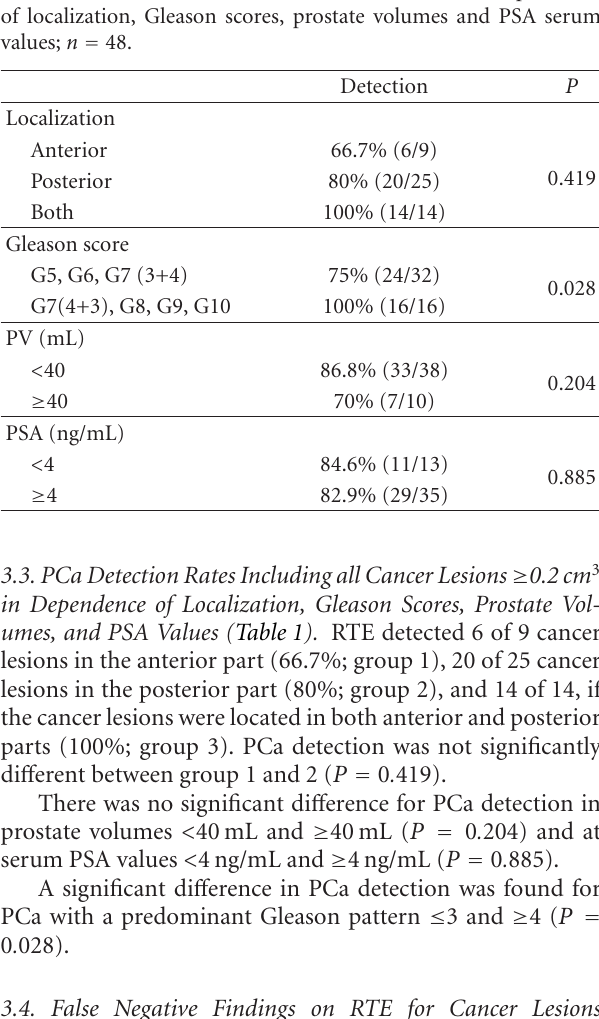
Figure 3: Detection rate based on tumor volume.